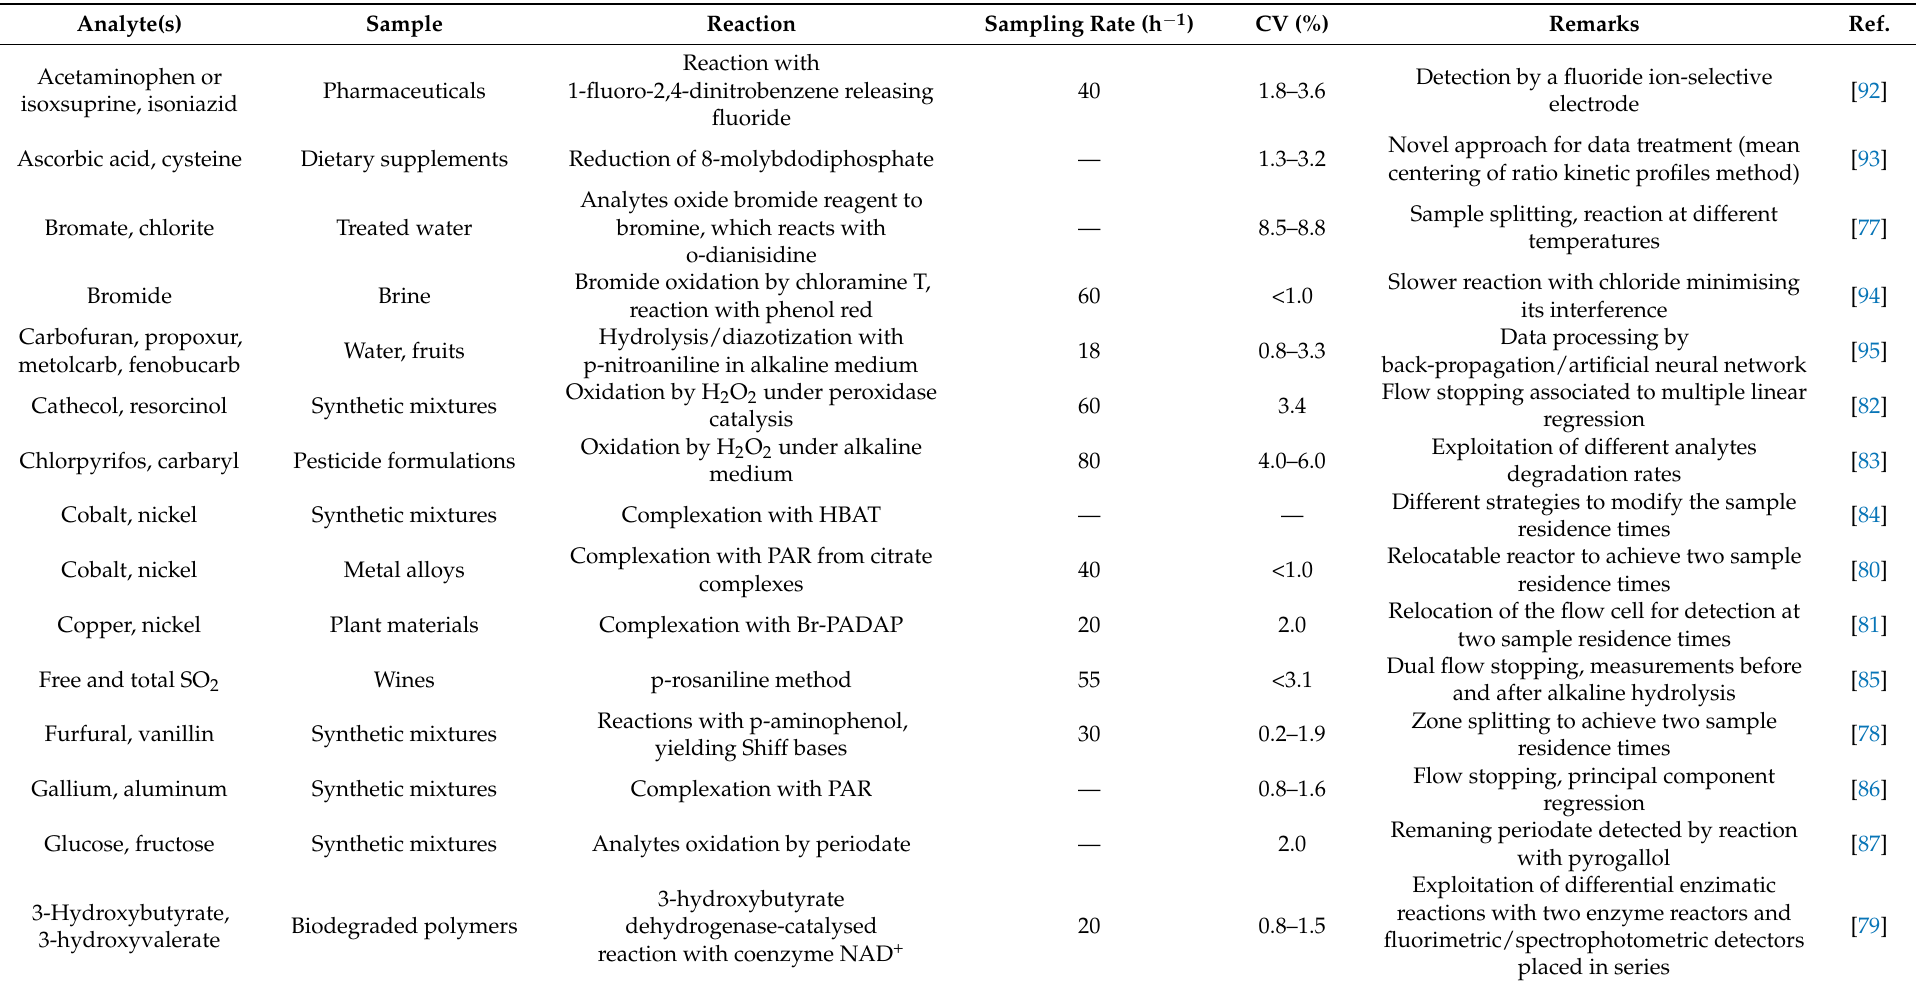
Table 1. Examples of kinetic discrimination in flow